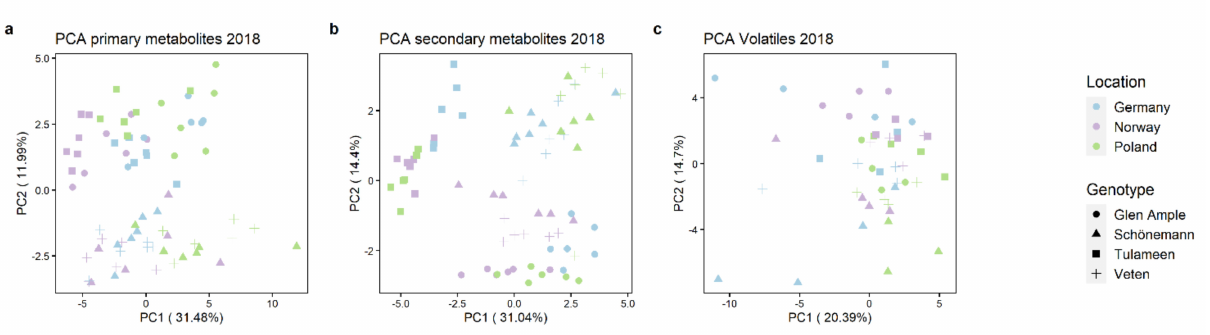
Figure 5. Principal component analysis (PCA) plots showing distributions for primary metabolites ( a ), secondary metabo- lites ( b ) and volatiles ( c ) of raspberry fruits. Each dot represents an individual sample, with shapes indicating the different raspberry cultivars, and colors the different locations. PC1 and PC2 represent the first and the second principal compo- nent,